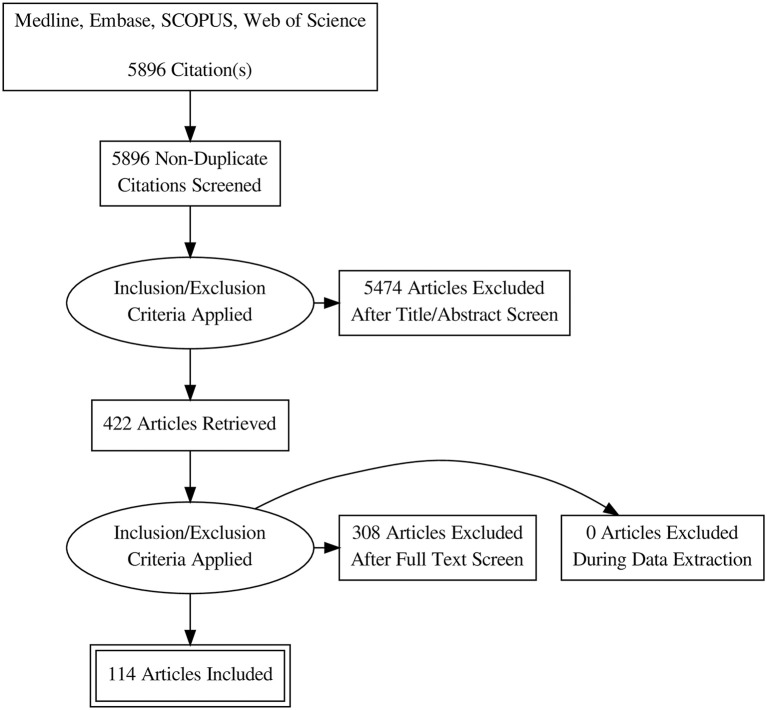
PRISMA flow diagram of literature search and study selection.